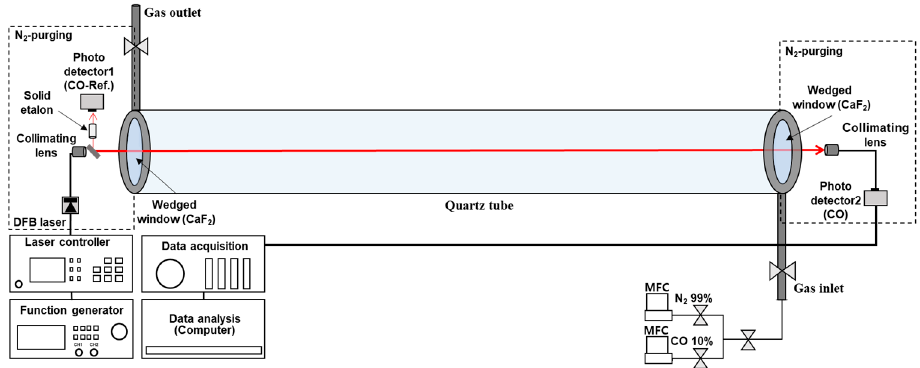
Figure 2. Schematic of the optical setup used for the preliminary experiment.